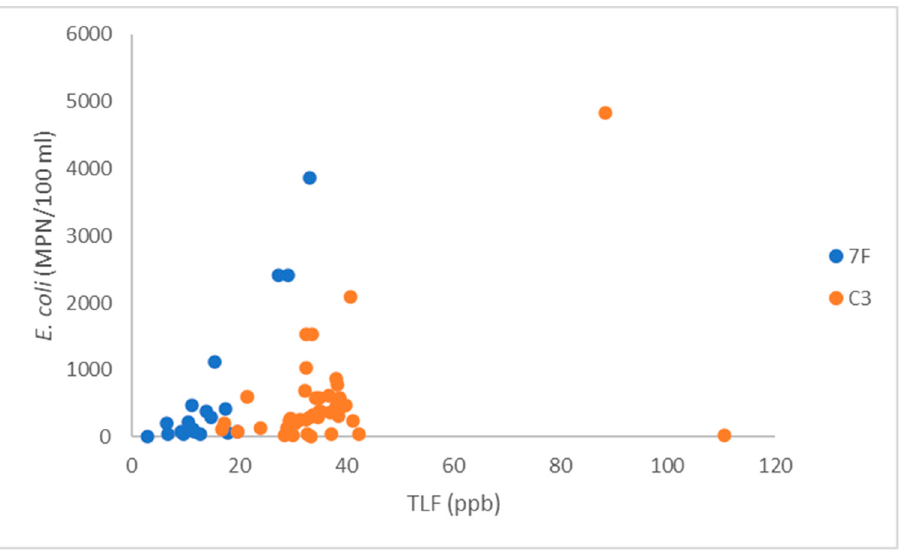
Figure 2. E. coli concentrations plotted versus TLF concentrations measured by the 7F and C3 fluo- rometers.